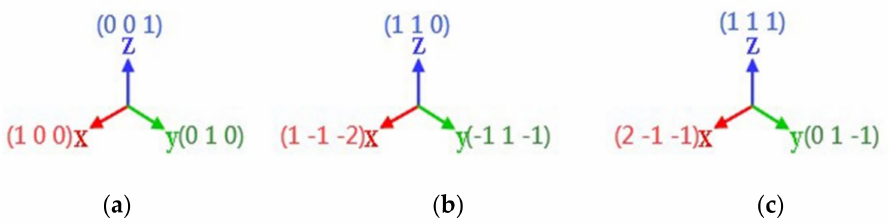
Figure 2. Coordinate axis setting of three crystal plane loading tests. ( a ) (001)coordinate ( b ) (110)coor- dinate ( c ) (111)coordinate.